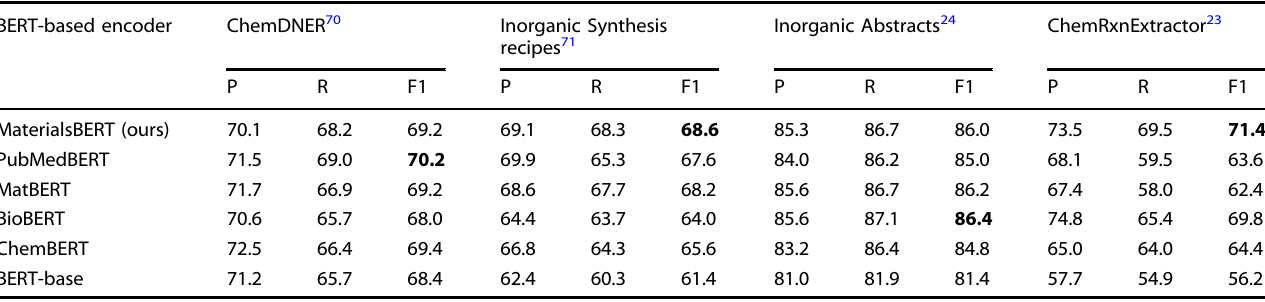
Table 3. Performance of different BERT-based encoders on the test sets of publicly available materials science NER